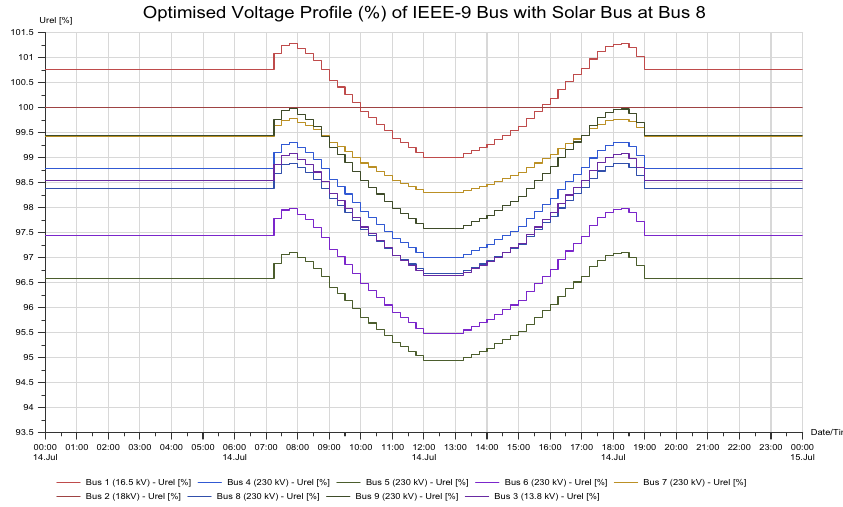
Optimised Voltage Profile (%) of IEEE-9 Bus with Solar Bus at Bus 8